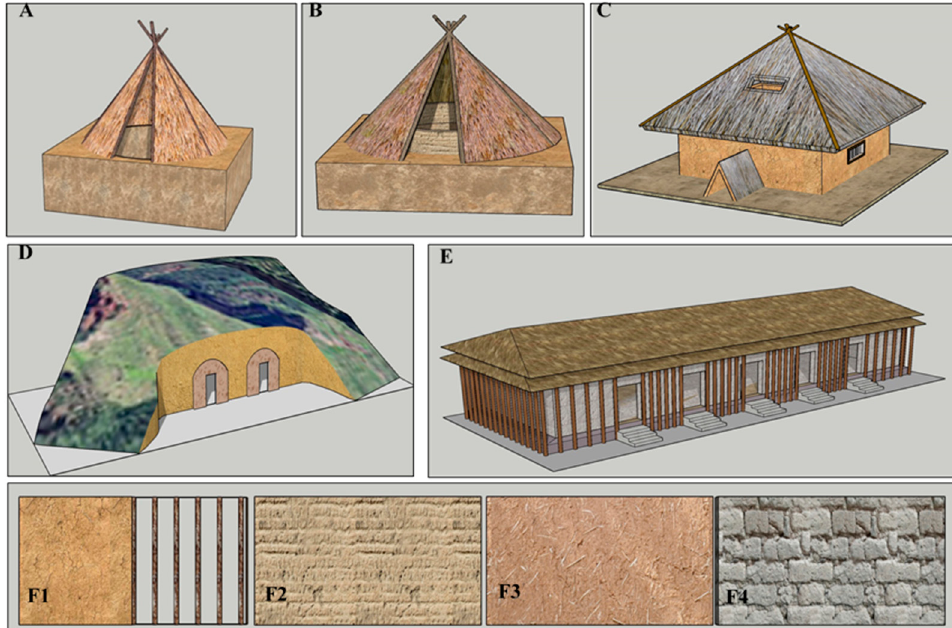
Figure 4. The shapes and forms of ancient houses: ( A ) semi pithouse without walls; ( B ) semi pithouse with low walls; ( C ) surface building; ( D ) cave dwelling; ( E ) palace, it was redrawn from HPICRA (2001) [16]; ( F1 ) wood skeleton mud wall; ( F2 ) rammed earth wall; ( F3 ) piled mud-grass mixed wall; ( F4 ) adobe wall.